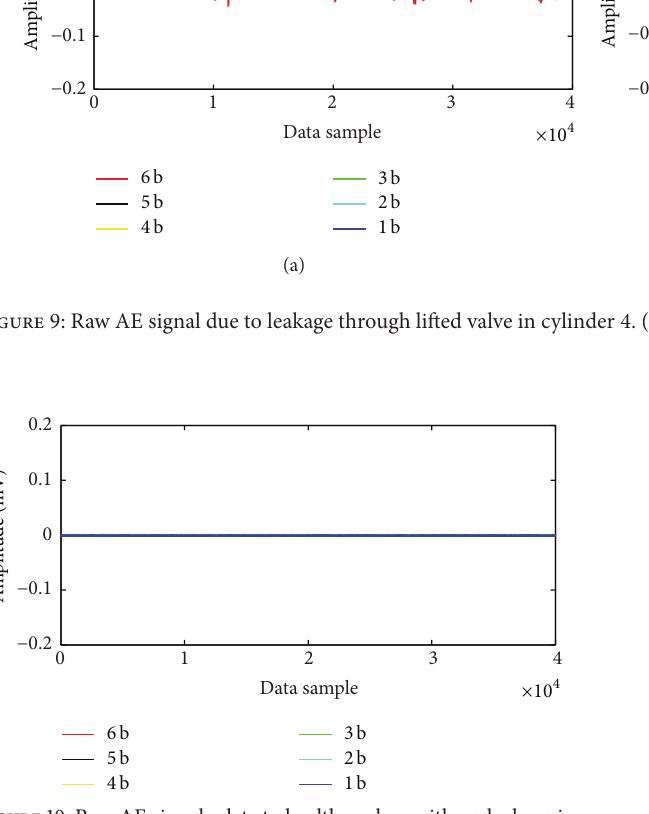
Figure 10: Raw AE signal relate to healthy valves with no leakage in cylinder 4.